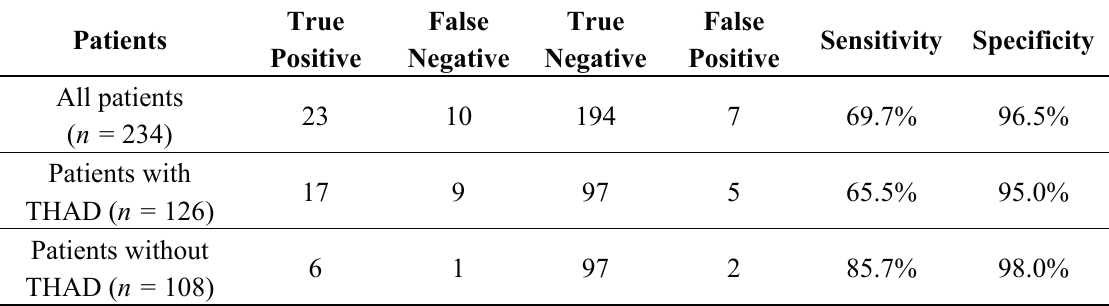
Table 1. Summed results for all three observers compared with the gold standard and shown for all patients, for patients with THAD and for patients without THAD. Mean sensitivity and specificity for the three observers are given for each comparison.